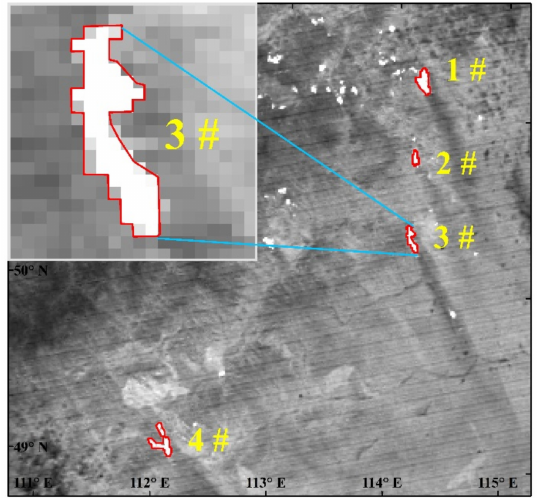
Figure 4. Burned area from MODIS band 21, and the upper-left corner is the enlarged images of the 3# fire scar.